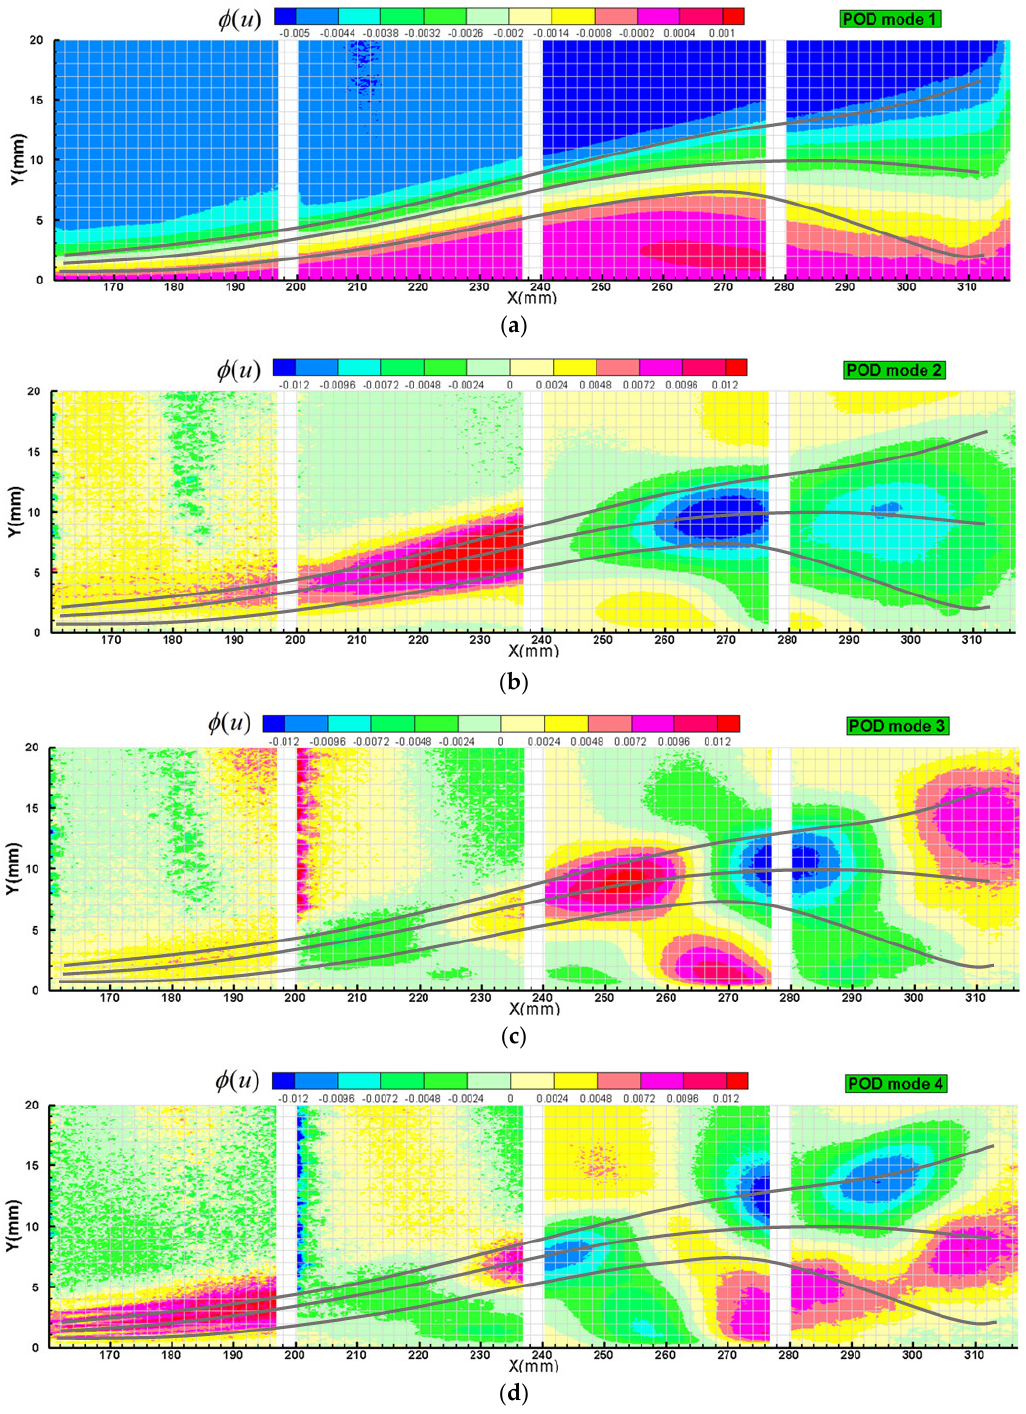
Figure 8. POD modes of streamwise velocity: ( a ) the first order mode; ( b ) the second order mode; ( c ) the third order mode; and ( d ) the forth order mode.